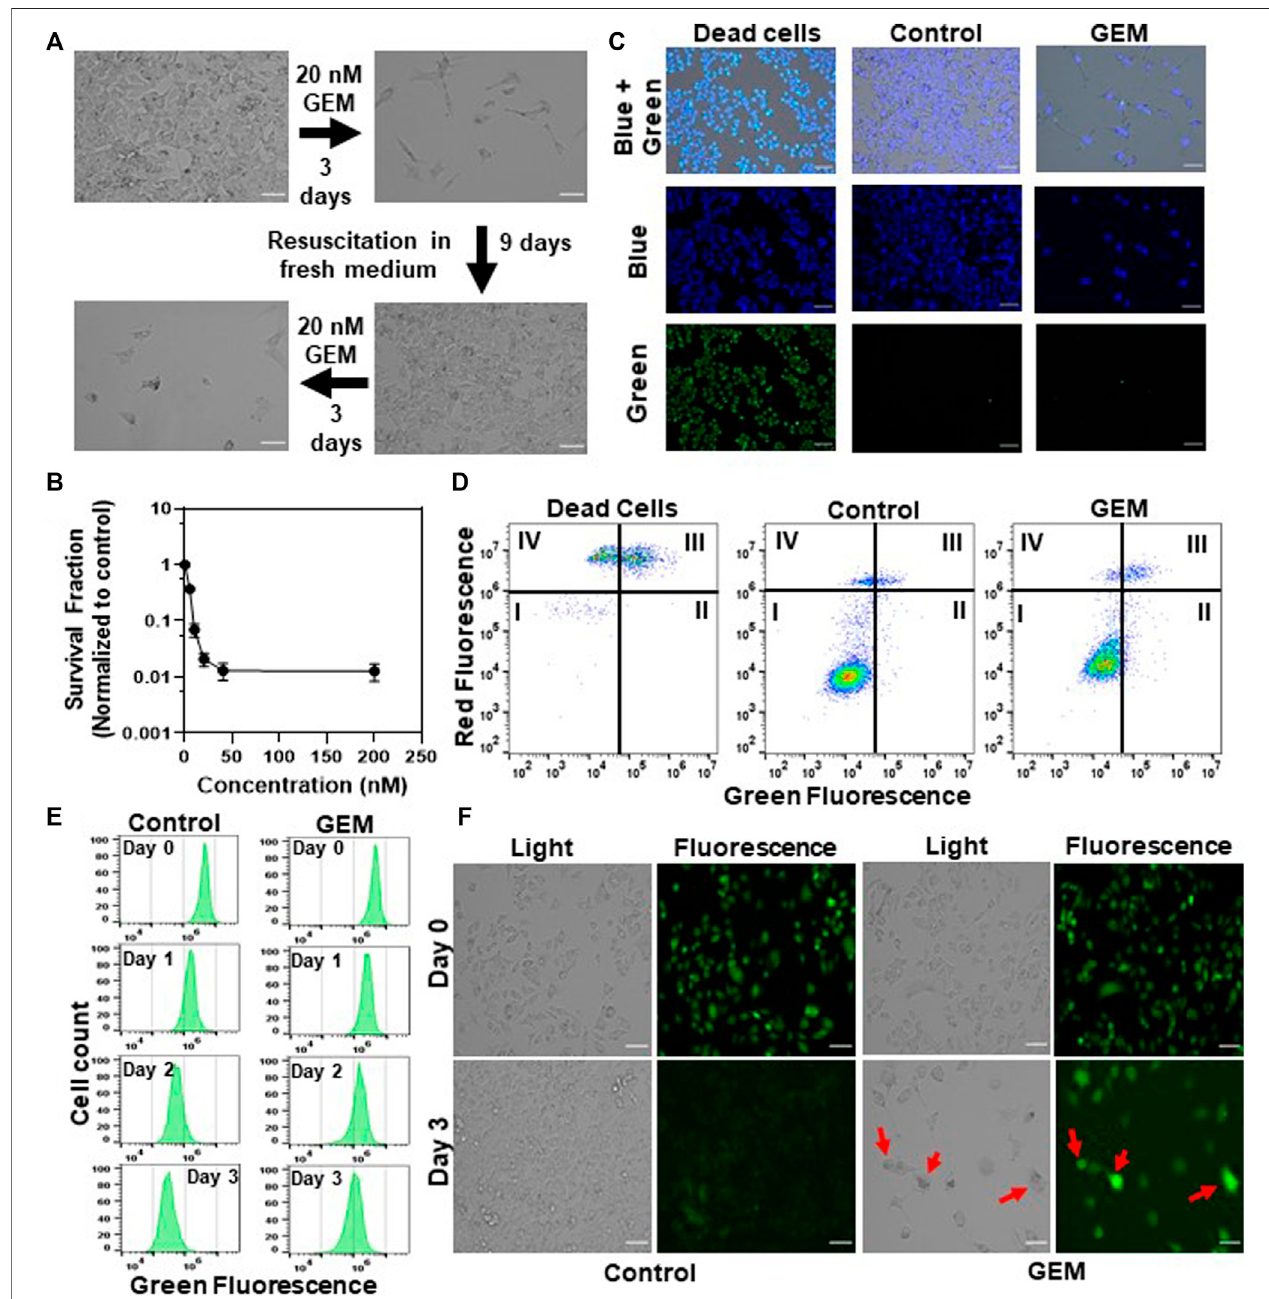
FIGURE 1 | Isolating drug-tolerant persister cells: (A) A375 melanoma cells were treated with GEM (10xIC 50 (cid:1) 20 nM, see Supplementary Table S2 ) for 3 days. After the treatment, cells were allowed to recover in fresh, drug-free growth medium and then treated with GEM after recovery to demonstrate the sensitivity of the daughter cells to GEM. Scale bar: 100 µm. (B) A375 cells were treated with GEM at the indicated concentrations for 3 days. The surviving cells after the treatment were collectedandtransferredtofreshmedium withoutGEM.Thefollowingday,cellviabilitywasassessed bytrypanblue staining(see MaterialsandMethods ).Survival fractions were calculated by normalizing the surviving cell numbers to those in the untreated control groups. The number of biological replicates ( N ) (cid:1) 4. (C) The cells survivingafterGEMtreatmentwerecollectedandtransferredtofreshmediumwithoutGEM.Thefollowingday,cellswerestainedwithReadyProbesCellViabilityImaging dyes to assess live and dead cells. The blue probe stains the nuclei of all cells, and the green probe only stains the nuclei of cells with compromised membranes. Dead cellsweregeneratedbytreatingthecellswith70%ethanolfor30 min. “ Control ” representsthelivecellsthatdidnotreceiveGEMtreatment.Scalebar:100 µm. (D) Cells after GEMtreatmentwerecollectedandtransferredtofreshmedium without GEM.Thefollowingday,cellswerestainedwithFITC-annexin-V conjugateand PItodetect apoptoticcells.Thequadrantsofthisgraphrepresent(I)live(FITC-/PI-),(II)earlyapoptotic(FITC+/PI-),(III)lateapoptotic(FITC+/PI+)and(IV)dead(FITC-/PI+)cells. (E,F) Melanoma cells prestained with CFSE dye were treated with GEM or left untreated (control), and their fl uorescence intensity was monitored at the indicated time points with fl ow cytometry (E) or fl orescence microscopy (F) . N (cid:1) 4. Scale bar: 100 µm.